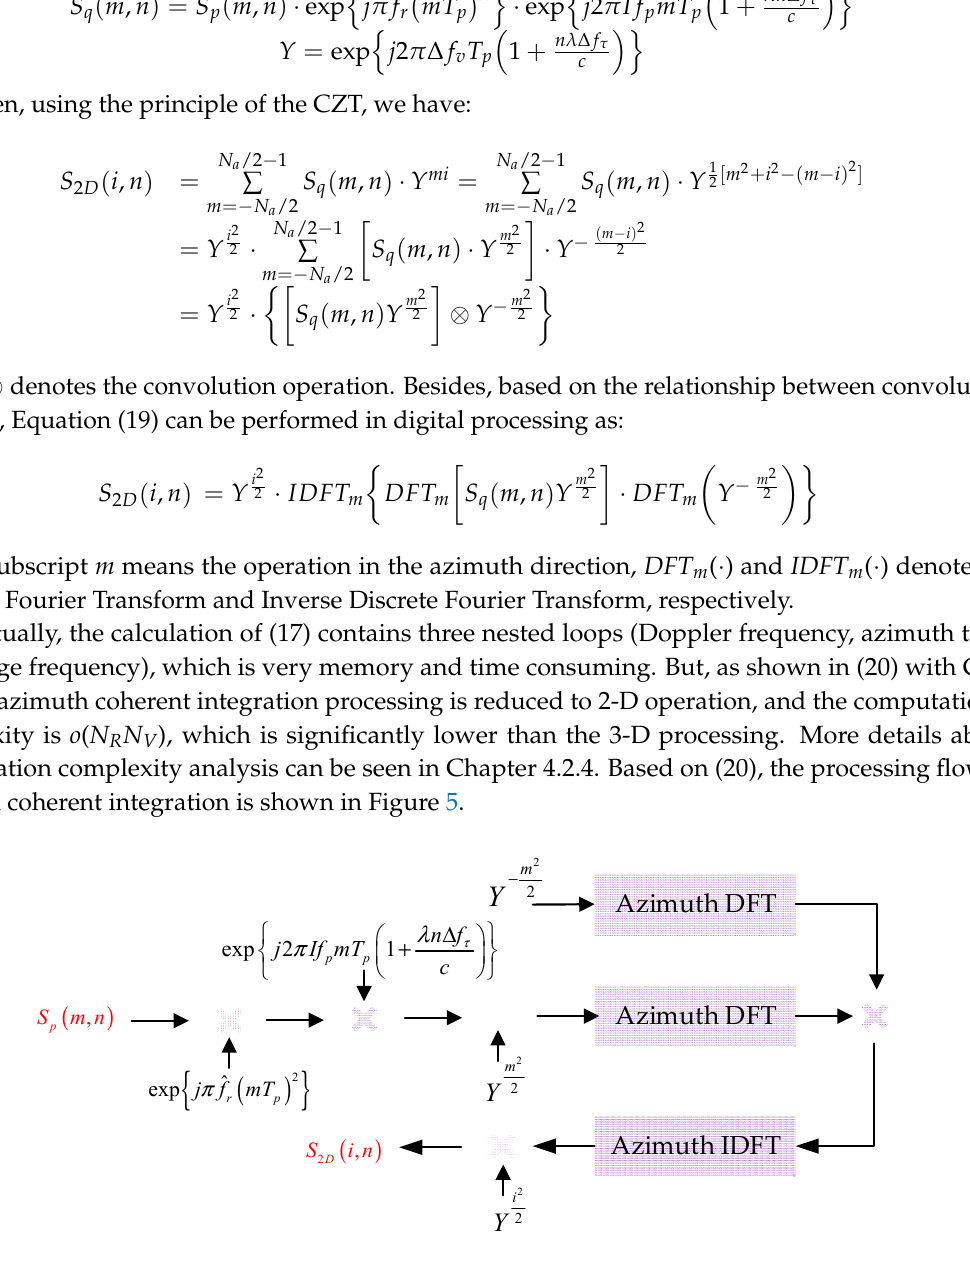
Figure 5. Processing steps of the fast implementation for azimuth coherent integration.